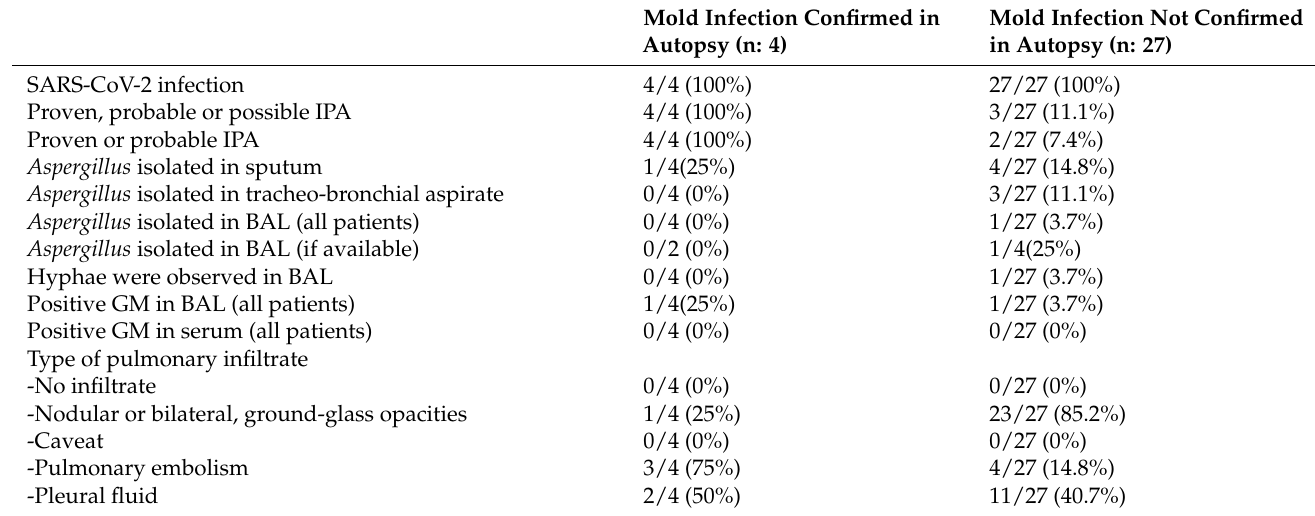
Table 5. Characteristics of patients with autopsy study